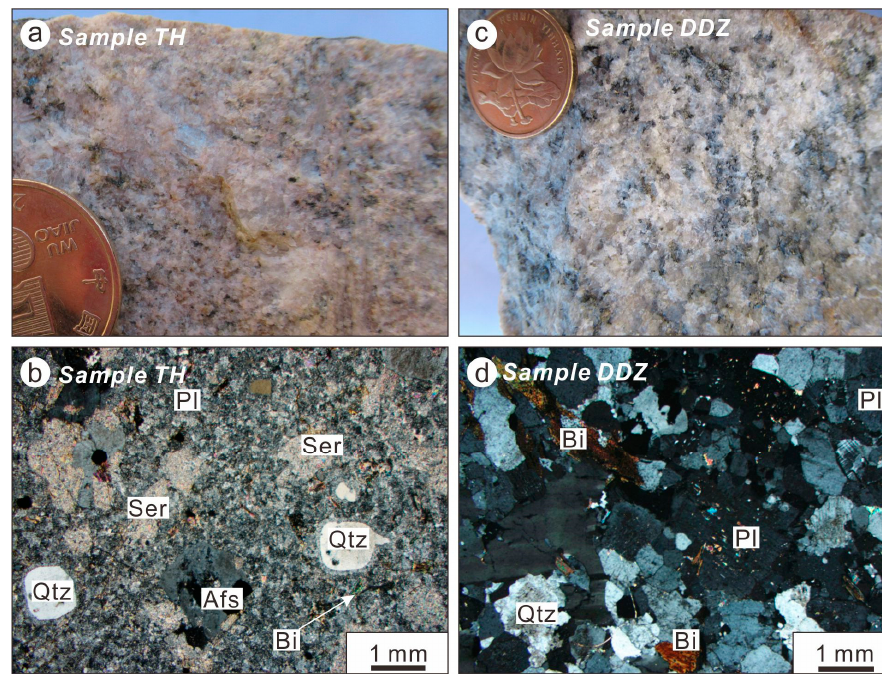
Figure 3. Hand specimens and microphotographs (cross-polarized light) of the Paleoproterozoic magmatic rocks in Qingchengzi district. ( a , b ) granite porphyry; ( c , d ) biotite granite. Abbreviations: Qtz = quartz; Afs = alkali feldspar; Ser = sericitization; Pl = plagioclase; Bi = biotite.